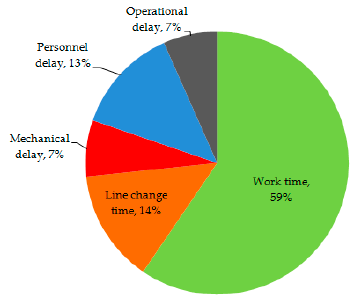
Figure 4. Breakdown of worksite time by main work activities for the 12 grapple yarder teams in the study.